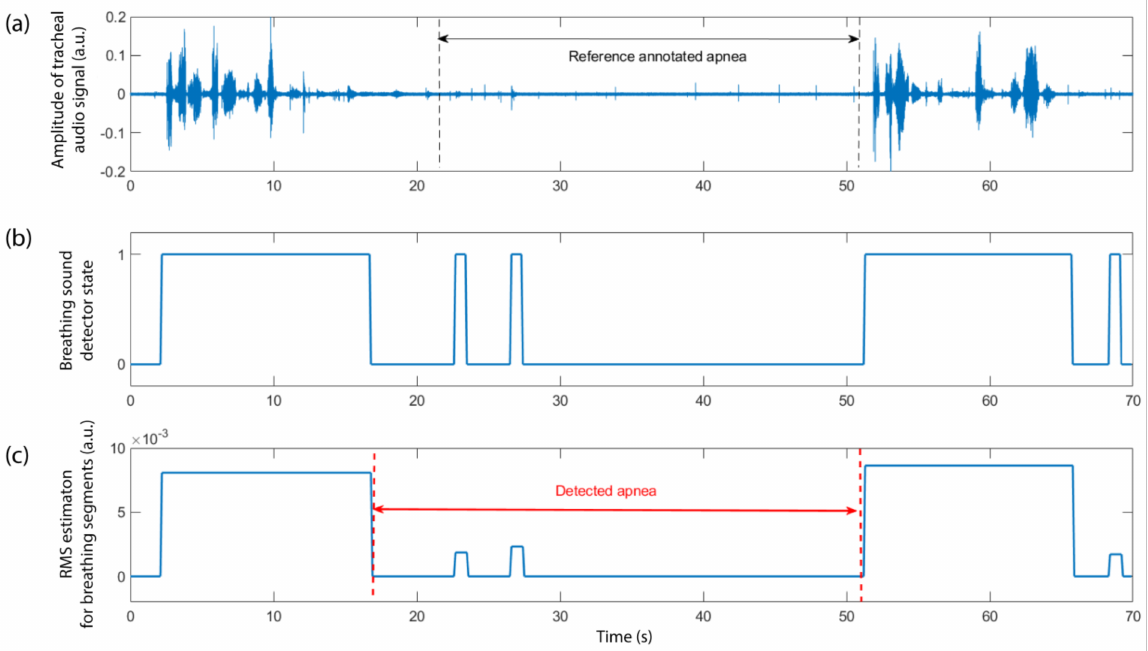
Figure 3. Steps of the described methodology for extracting the apnea/hypopnea event detector based on the raw audio signal: ( a ) The audio signal, in this case, is recorded from the trachea of the patient. The annotated reference apneic event, from approx. the 22nd s until the 51st s of the represented signal excerpt is denoted by the two vertical dashed lines. The breathing activity is obvious before and after the event, while some low-level audio activity can also be observed during the event. ( b ) The breathing detector state, as described in Section 2.3, results in the detection of all breathing activity within the selected audio excerpt (1 denotes active, 0 denotes inactive). ( c ) The weighted detector, in which instead of 0 and 1 (corresponding to silence and breathing states), we have 0 for silence and non-zero values corresponding to the mean RMS of the audio signal within each detected breathing frame. The detected apneic event is also